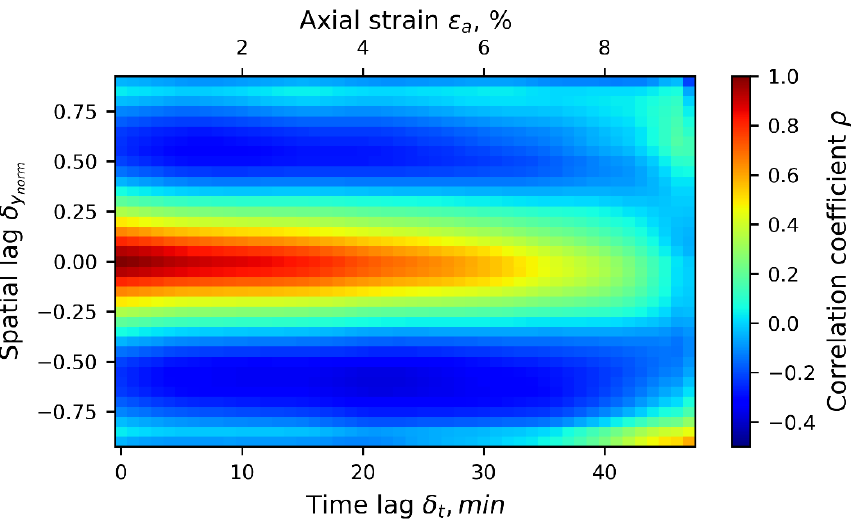
Figure 10. Spatio-temporal empirical correlation map of 1D-T radial data ensemble.